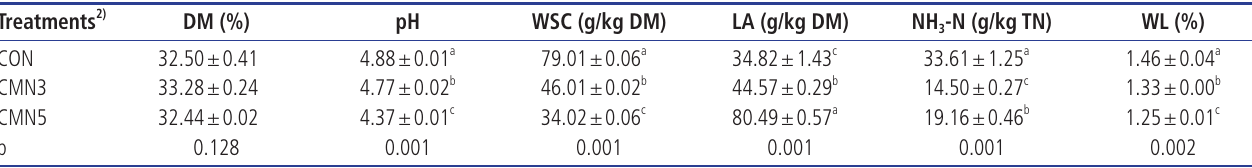
Table 4. Fermentation quality of alfalfa silage ensiled for 120 days 1)